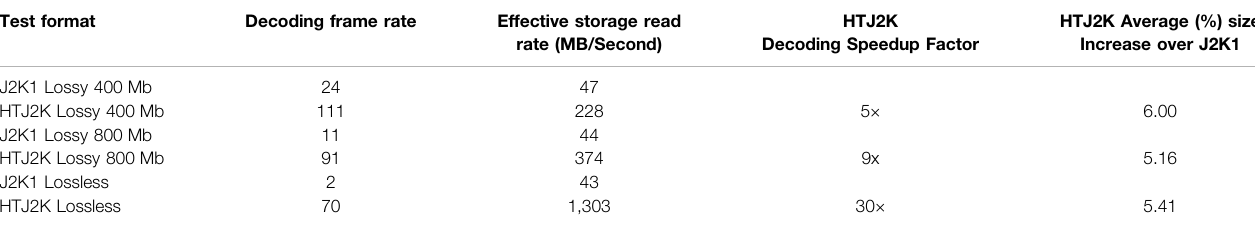
TABLE3| ComparisonofJ2K1andHTJ2Kcompressedsizesanddecodingthroughputovera10 sportionofthe Meridian shortin3,840×2,1604:4:4SDRBT.709format. The content is encoded fi rst using JPEG 2000 Part-1 (J2K1) and then losslessly transcoded to HTJ2K code-streams, using the HT block coding algorithm exclusively (i.e.,thereisnomixingofJ2K1andHTencodingoptionsinthetranscodedresult).Thetablereportstheincreaseincompressed sizeassociatedwiththemuchfasterHTJ2K representationofexactlythesameinformationastheJ2K1original,aswellasthedecodingthroughputsthatareachievedusingtheKakadu “ kdu_vex_fast ” application,ona MacBookPro15-inch2018platformwith2.9 GHzIntelCorei9(6-core)processor,16 GBRAMand1 TBSSD.Notethatthelabels “ HTJ2KLossy400 Mb ” and “ HTJ2K Lossy 800 Mb ” are indicative only; the actual HTJ2K bit-rates are larger by the amount indicated in the last column. Encoding throughput speedup factors for HTJ2K over J2K1 are substantially